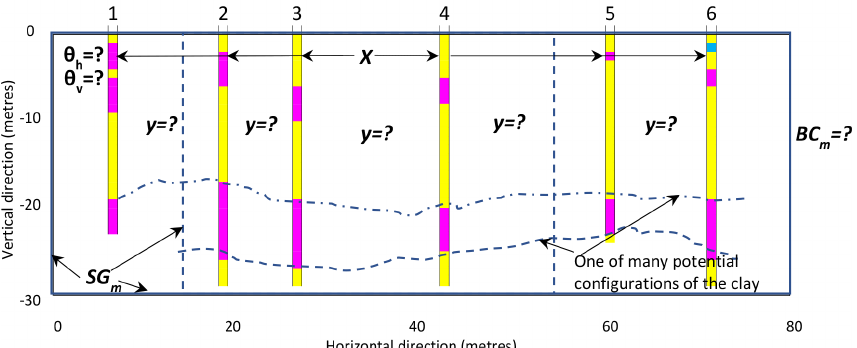
Figure 2. Borehole logs in colours and longitudinal section reported by Zhao et al. (2021) located in the Central Business District, Perth, Western Australia. The records correspond to information on six boreholes. Three types of materials are revealed by the boreholes, including sand (yellow), clay (magenta), and gravel (blue).